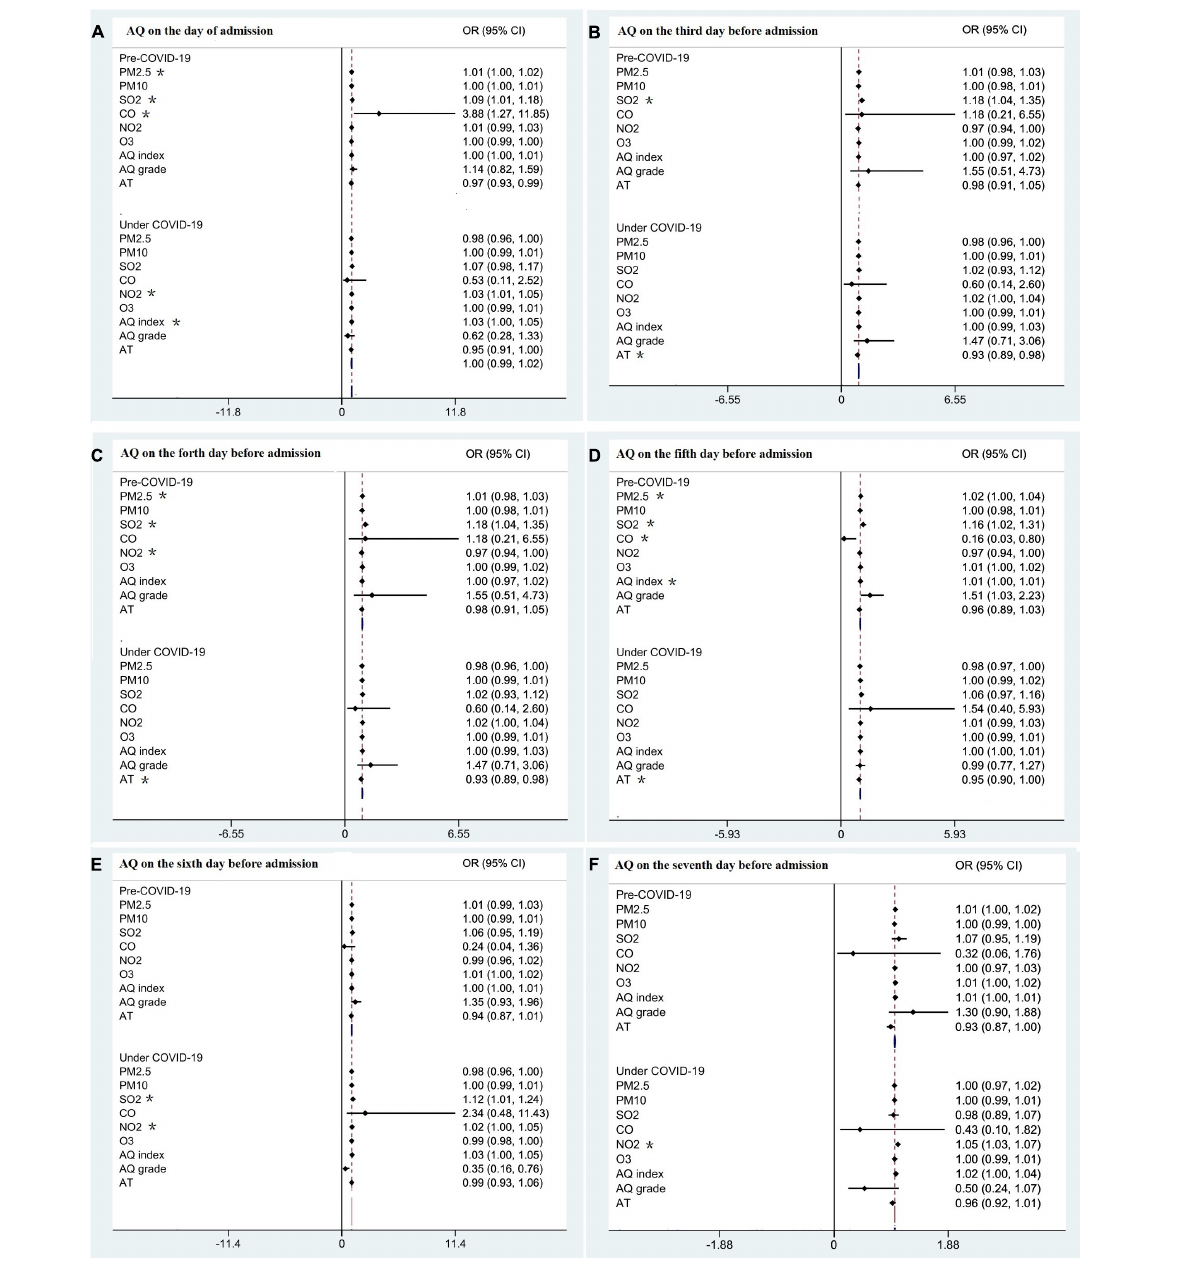
is longer than another study in Beijing (11).